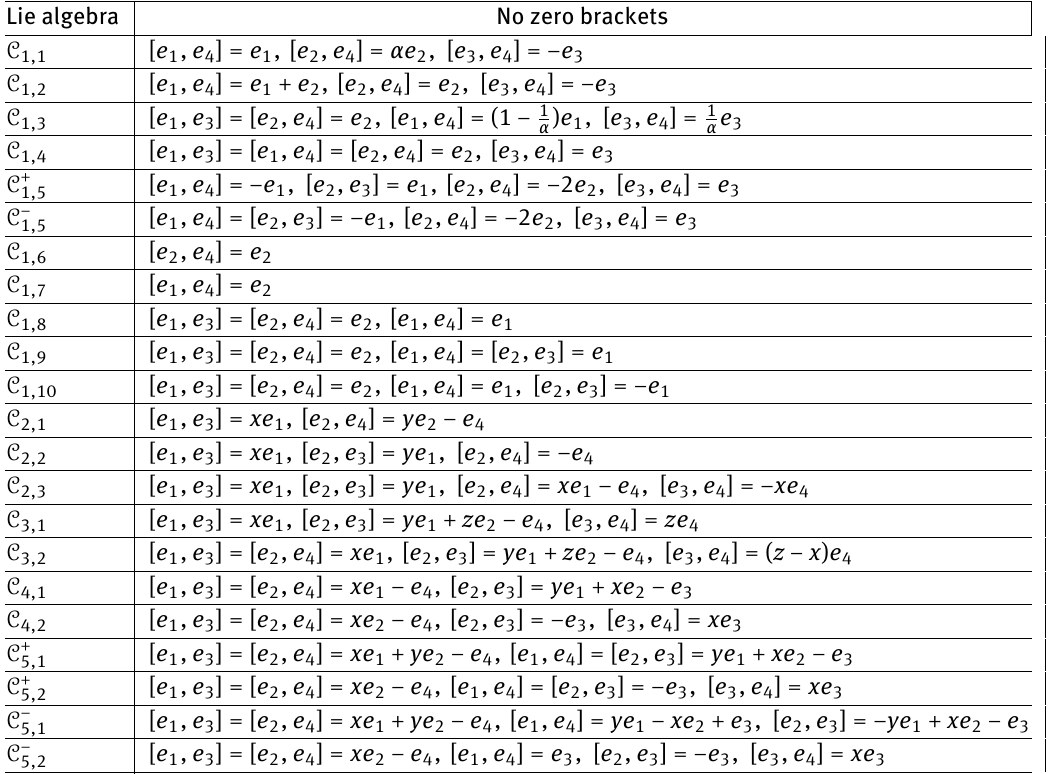
Table 5: Four-dimensional Para-Kähler Lie algebras coming from c Lie algebra